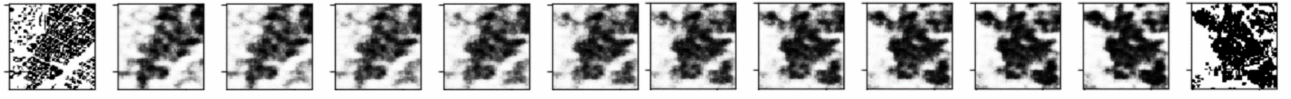
Figure 13. Results of Test 4. Interpolation between two data samples using decoder_200. The most left and right samples belong to the original dataset X. The rest of the images are out of the sample calculated based on the decoder prediction with an increment left to right, top to